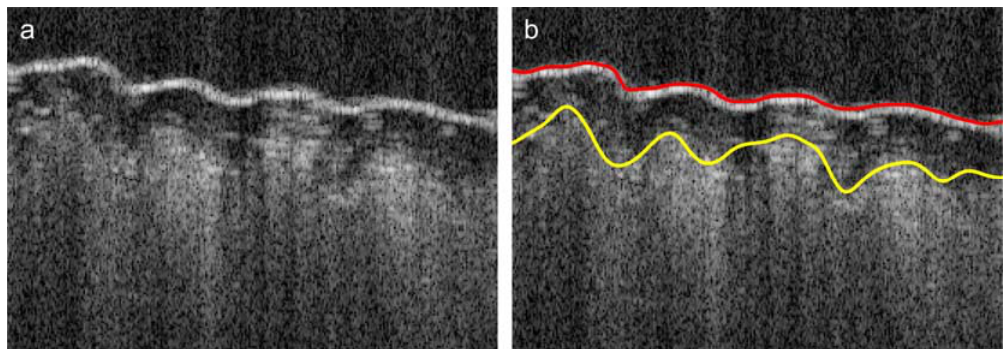
Figure 11. Example OCT C ‐ scan of a Cordura 4 (Camouflage, bottom rows of Figures 2 and 5) sample region R ( a ) with selected B ‐ scan in the YZ ‐ plane ( b ).